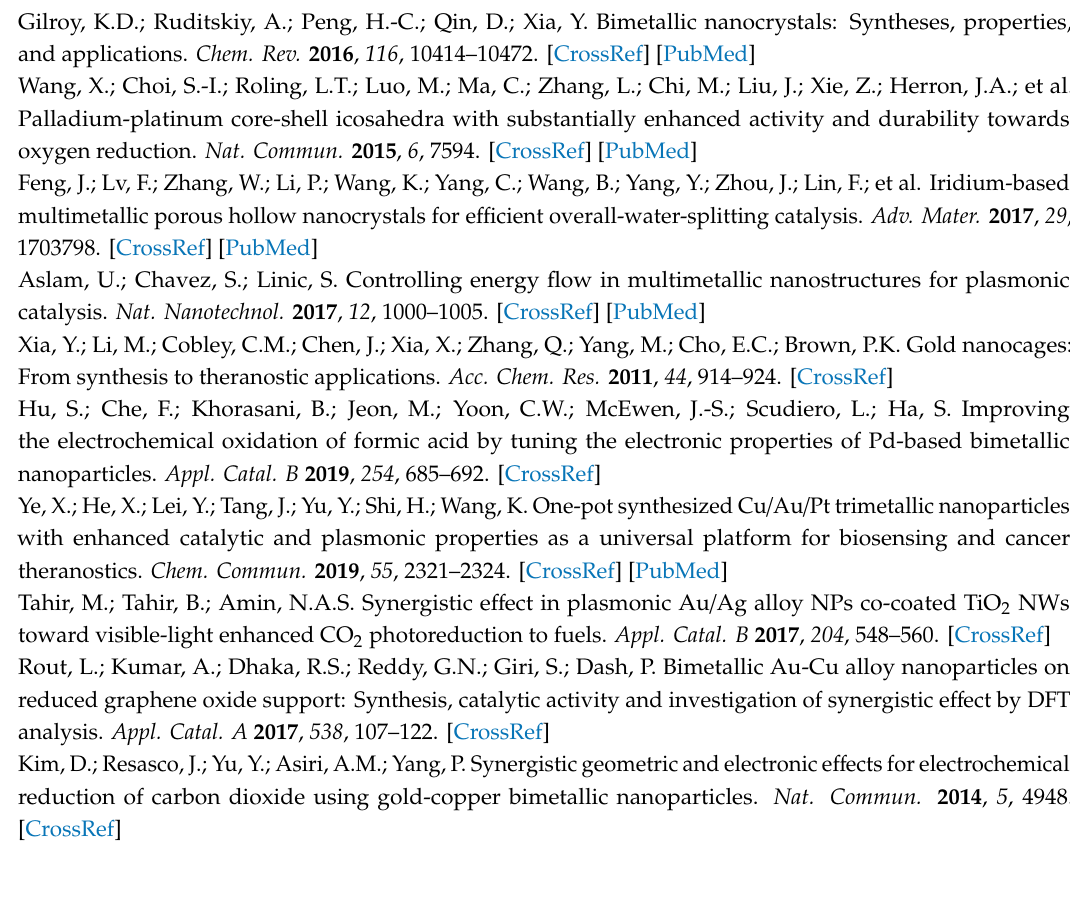
Figure S1. Size distributions of (a) AgPt-40, (b) AgPt-10, (c) AgPt-6.7, (d) AgPt-5, (e) AgPt-2, and (f) AgPt-1. Figure S2. Pt percent in Ag nanoparticles synthesized at di ff erent atomic ratios of Ag to Pt in precursors (the atomic ratio of Ag to Pt in nanoparticles is shown in the brackets). Figure S3. EDS mapping images of (a) AgPt-40, (b) AgPt-10, (c) AgPt-6.7, (d) AgPt-5, (e) AgPt-2, and (f) AgPt-1. Figure S4. High resolution TEM (HRTEM) images of AgPt-6.7. Figure S5. (a, b) XRD patterns and (c) UV-vis spectrum of as-prepared AgPt nanoparticles. Figure S6. Size distributions of (a) AgPd-1, (a) AgPd-0.8, and (c) AgPd-0.66. Figure S7. EDS mapping images of as-prepared AgPd nanoparticles with di ff erent Ag / Pd atomic ratios. The Ag / Pd atomic ratios were (a) 1.3, (b) 1, (c) 0.8, and (d) 0.66. Figure S8. HRTEM images of AgPd-1. Figure S9. (a) Pd percent in AgPd nanoparticle obtained at di ff erent atomic ratios of Ag to Pd in precursors (the atomic ratio of Ag to Pd in nanoparticles is shown in the brackets), (b) XRD patterns, and (c) UV-Vis spectrum of the AgPd nanoparticles. Figure S10. Size distributions of as-prepared CuPt nanoparticles (a) CuPt-20, (b) CuPt-10, (c) CuPt-4. Figure S11. HRTEM images of CuPt-10. Figure